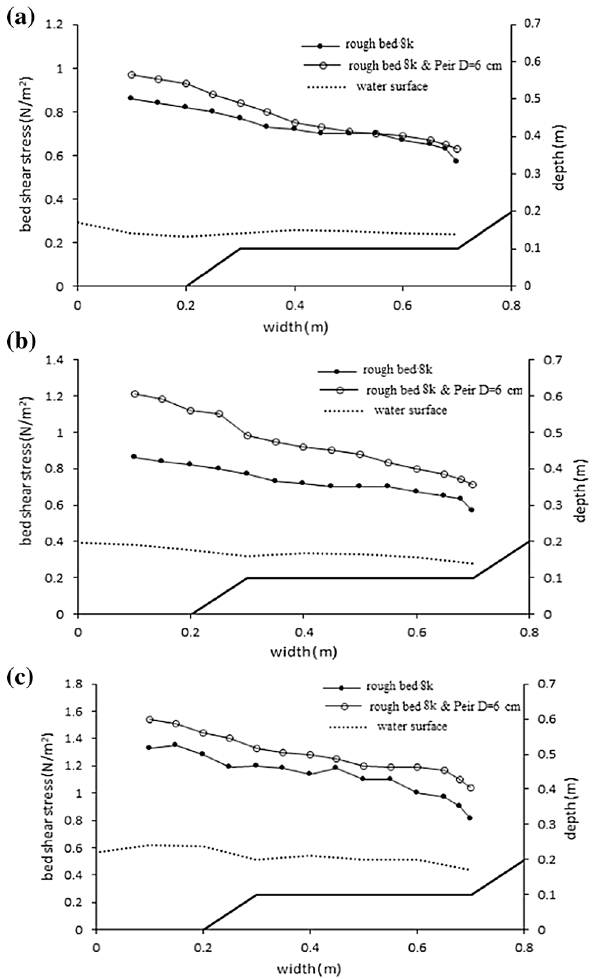
Fig. 8 Comparison of the bed shear stress in a roughened plain with the presence of a pier ( D = 6 cm) and roughened plain (distances of 8 k) a Q 1 , b Q 2 and c Q 3